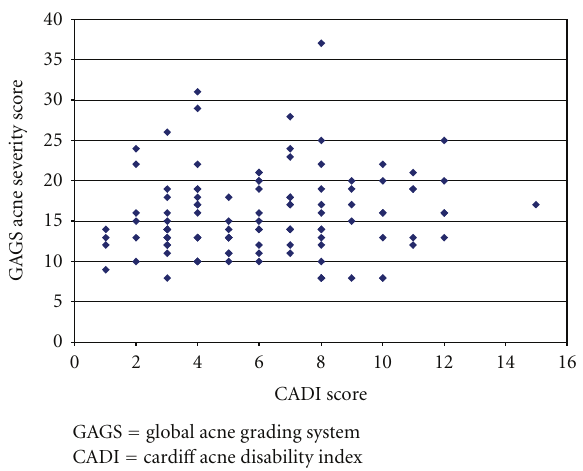
Figure 1: Distribution of cases according to GAGS acne severity score and CADI disability index score.